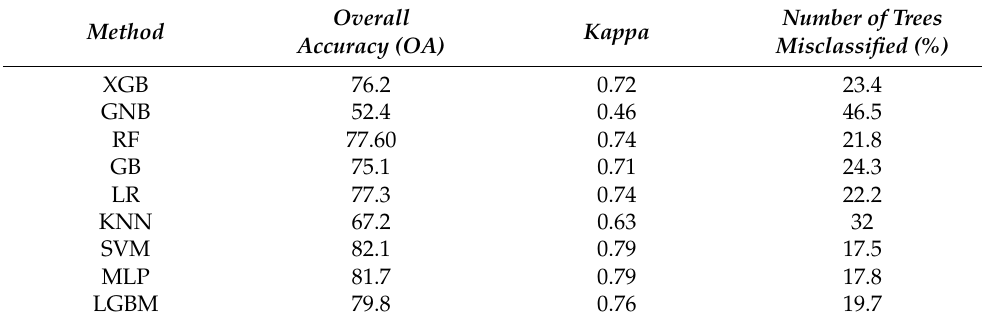
Table 4. Overall tree species classification accuracy, kappa coefficient, and total misclassified trees by using different machine learning